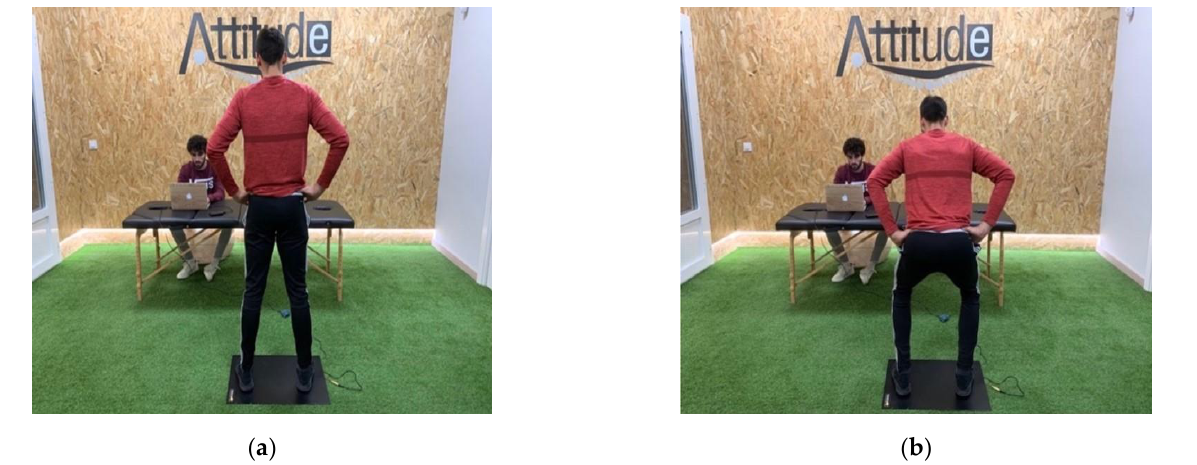
Figure 2. Countermovement jump measurement: ( a ) Starting position; ( b ) vertical jump after a fast-down countermovement.